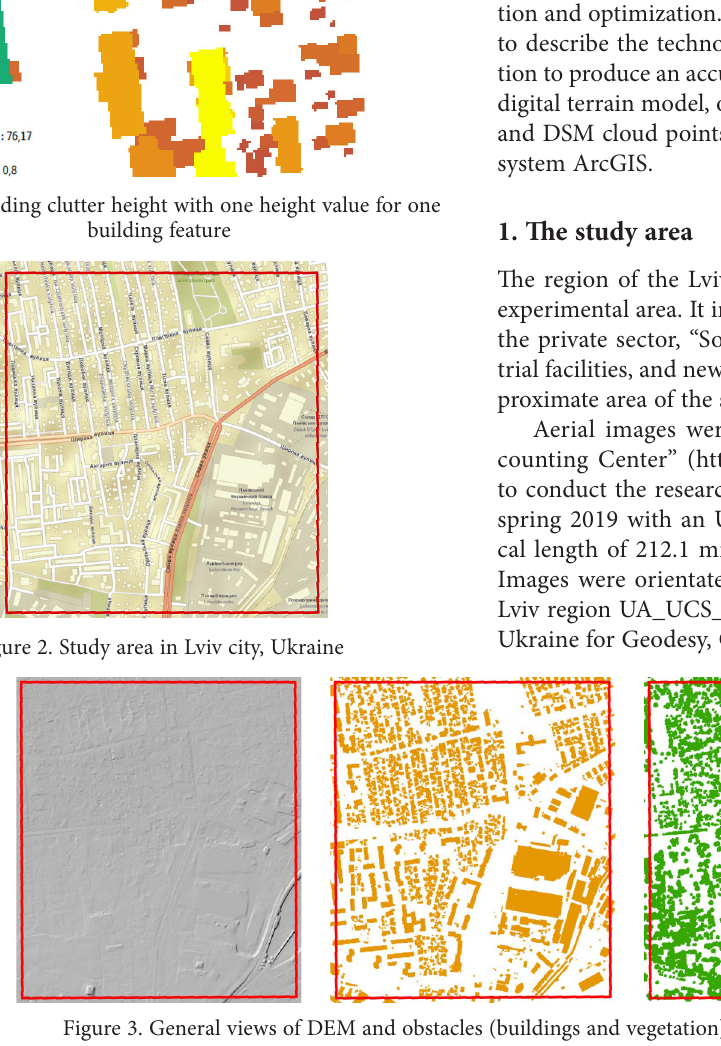
Figure 3. General views of DEM and obstacles (buildings and vegetation) at the study